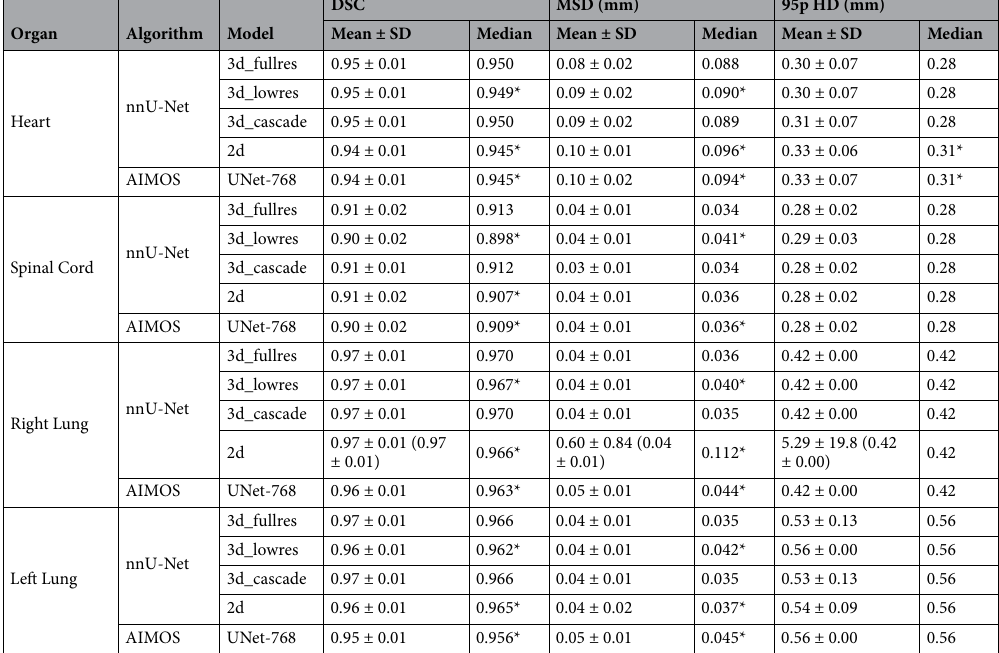
significant difference with the nnU-Net 3d full resolution model according to the Wilcoxon signed rank test with a significance level of α = 0.05 . Values in parentheses correspond to re-calculated metrics after connected component